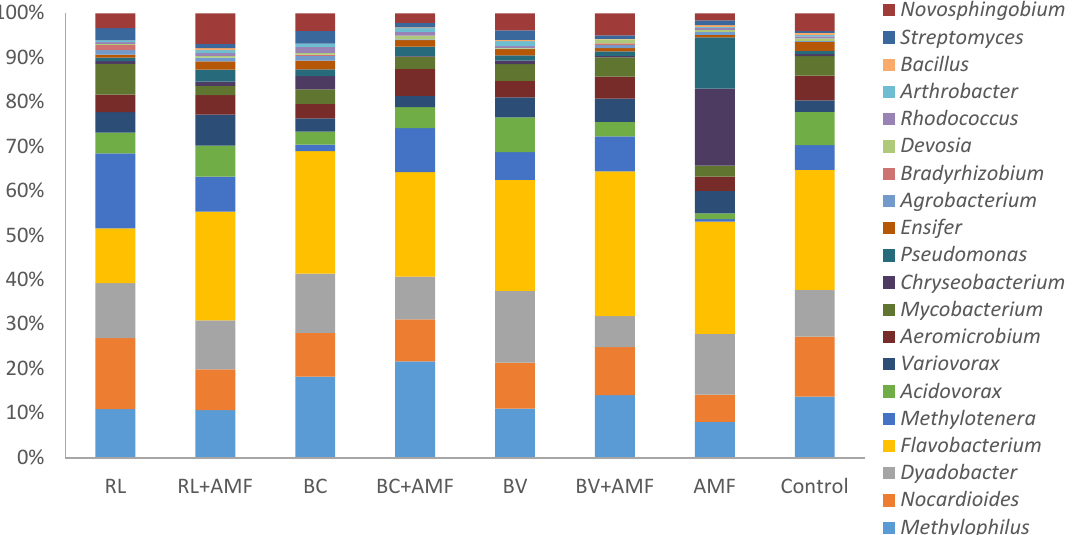
Figure 3. Relative abundance of different genera in fava bean nodules of the different inoculation treatments. The genus Rhizobium is not shown due to its high relative abundance, and the rest of the genera were relativized. Treatment: RL ( Rhizobium leguminosarum ), BC ( Burkholderia cenocepacia ), BV ( Burkholderia vietnamiensis ) and AMF (Arbuscular mycorrhizal fungi).